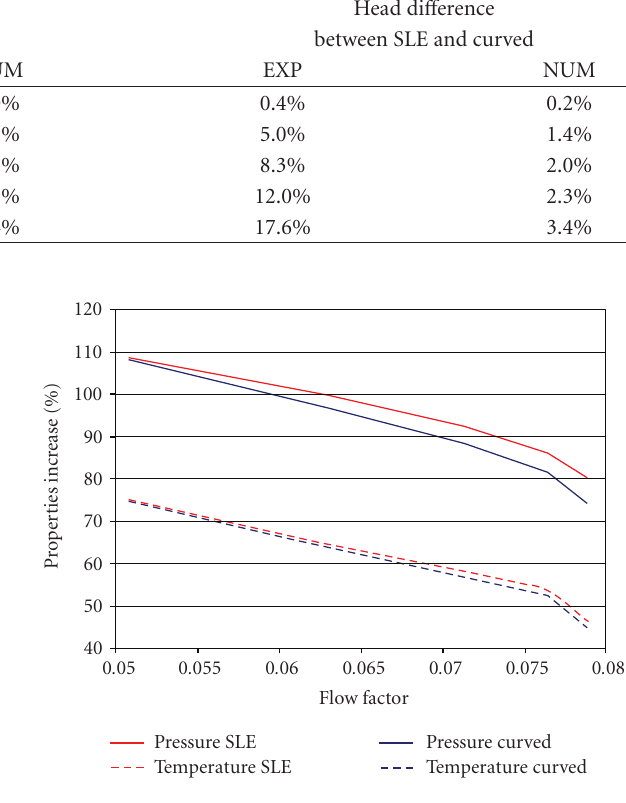
Figure 2: Compression e ffi ciency comparative results. Figure 3: Pressure and temperature increases for SLE and curved bladed impellers.